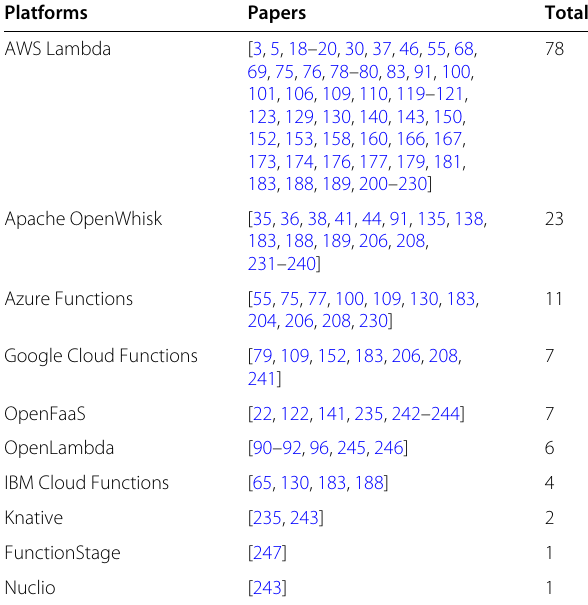
Table 7 Serverless platforms